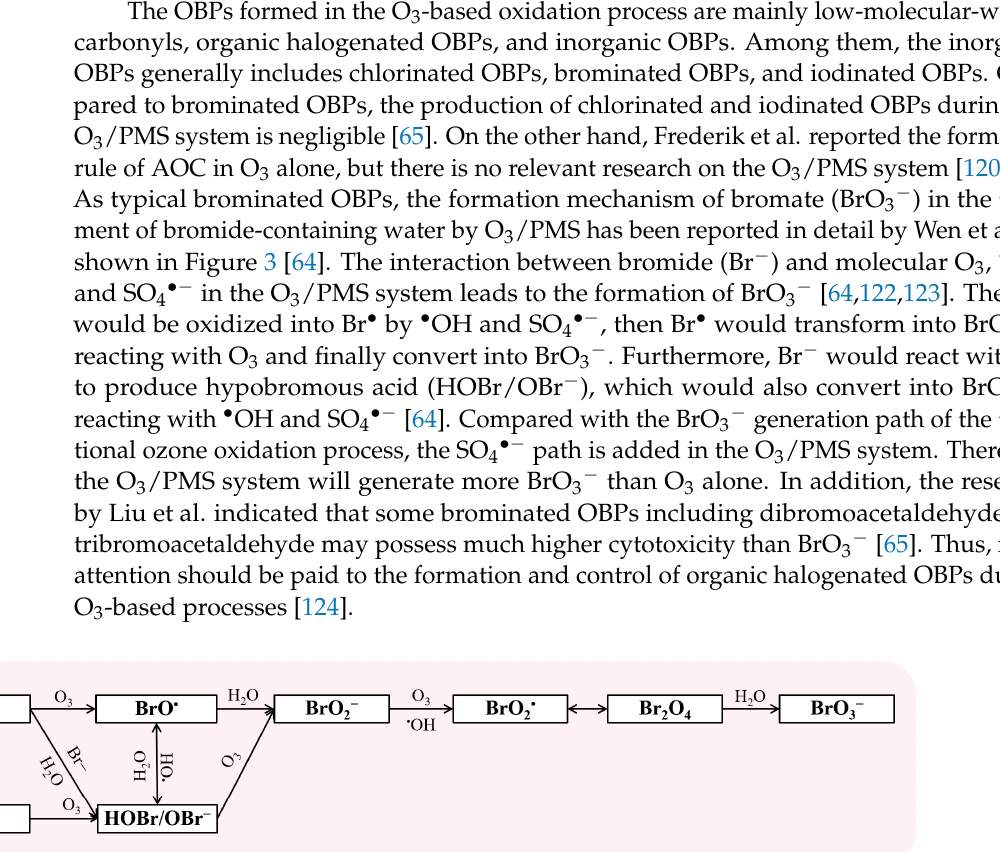
Table 4. The influence of reaction conditions on OBP formation.